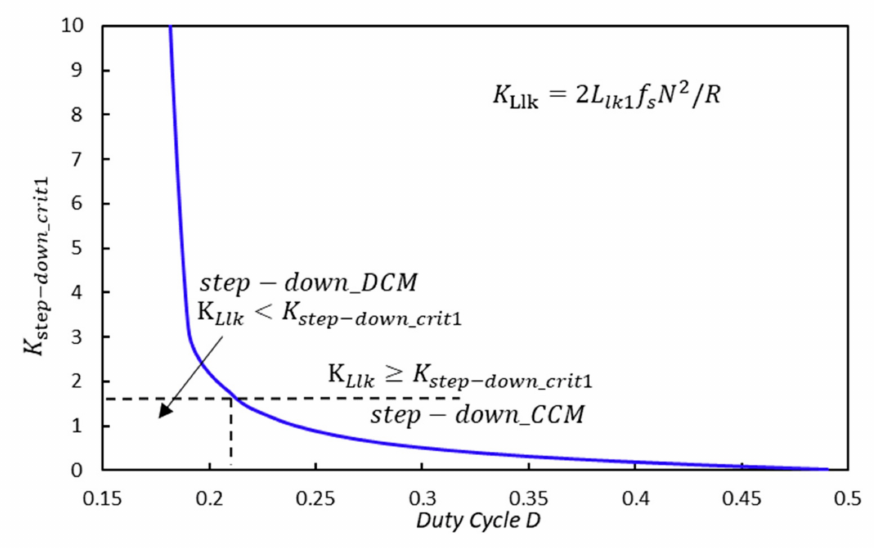
Figure 8. Boundary between step-down-CCM mode and step-down-DCM mode.